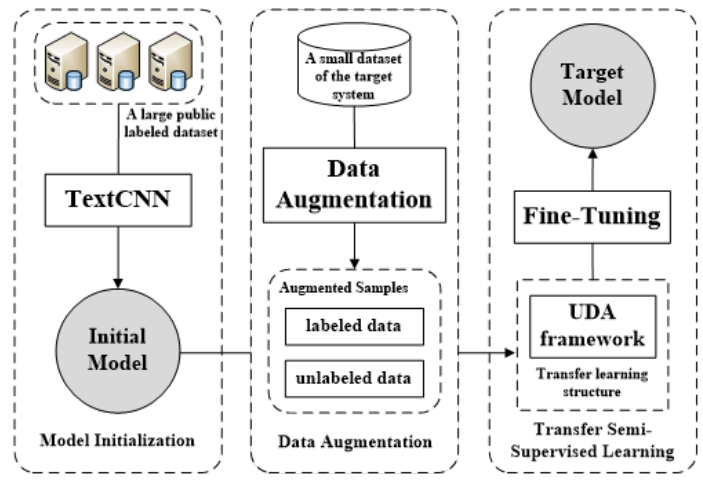
Figure 1. The architecture of